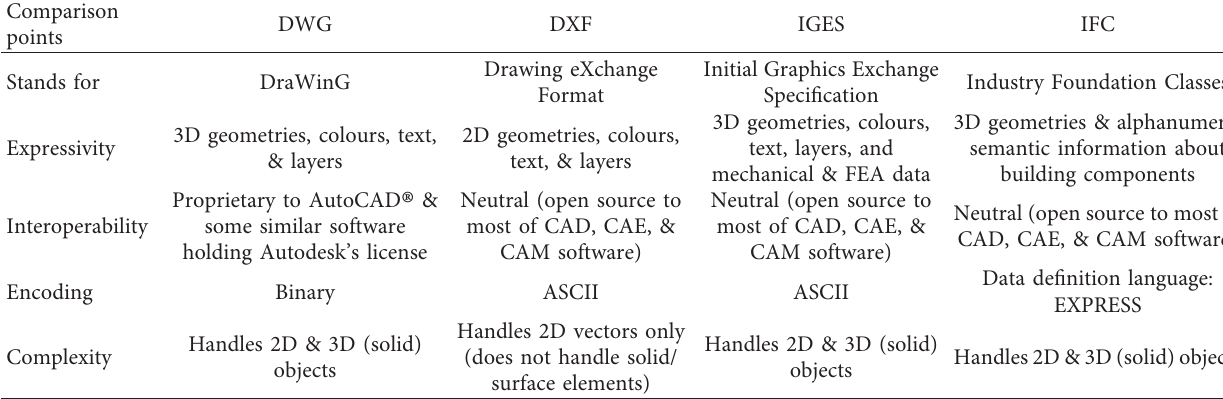
Table 2: Comparison of data formats